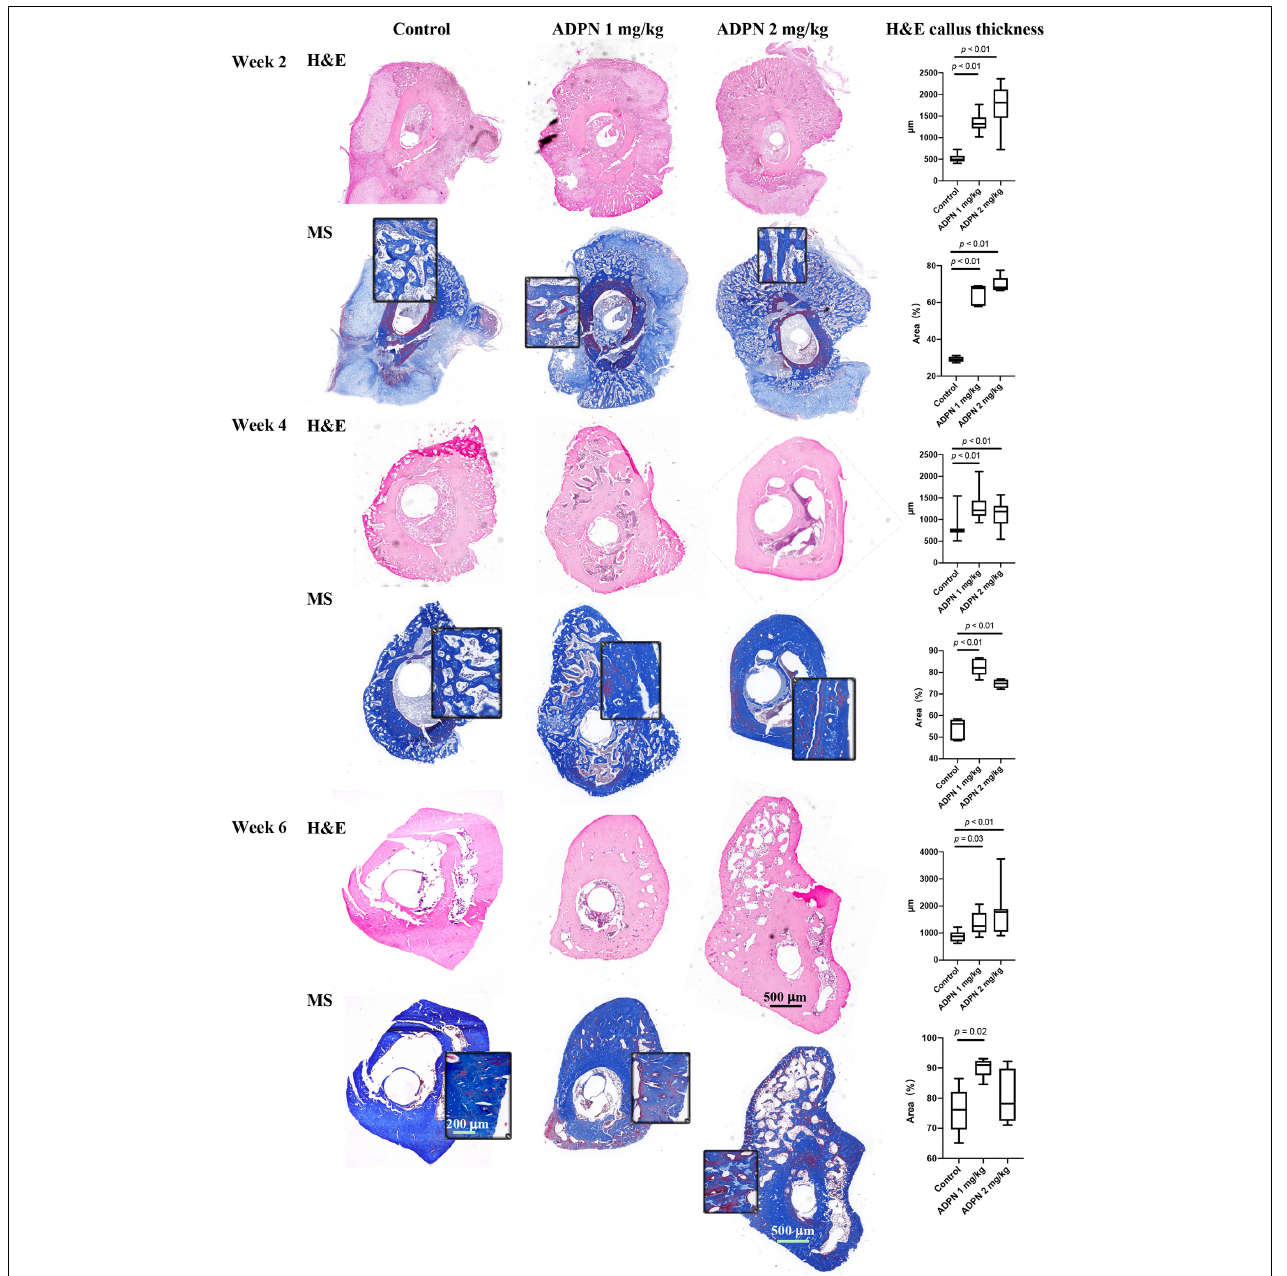
FIGURE 4 | Histology evaluation of bone regeneration. The hematoxylin and eosin (H&E) and Masson trichrome staining (MS) images of rat tibia transverse sections at weeks 2, 4, and 6 ( n = 5), scale bar = 500 µ m and scale bar = 200 µ m in the magnified images. The ADPN treatment groups showed thicker cortical bone and bone calluses. The callus thickness and the blue-stained area, indicative of new bone formation, were quantified and plotted.